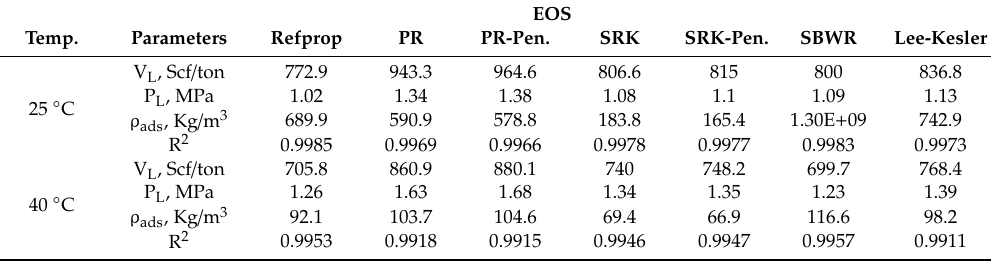
Table 3. Langmuir parameters for di ff erent equations of state (adsorption isotherms only). EOS Temp. Parameters Refprop PR PR-Pen. SRK SRK-Pen. SBWR